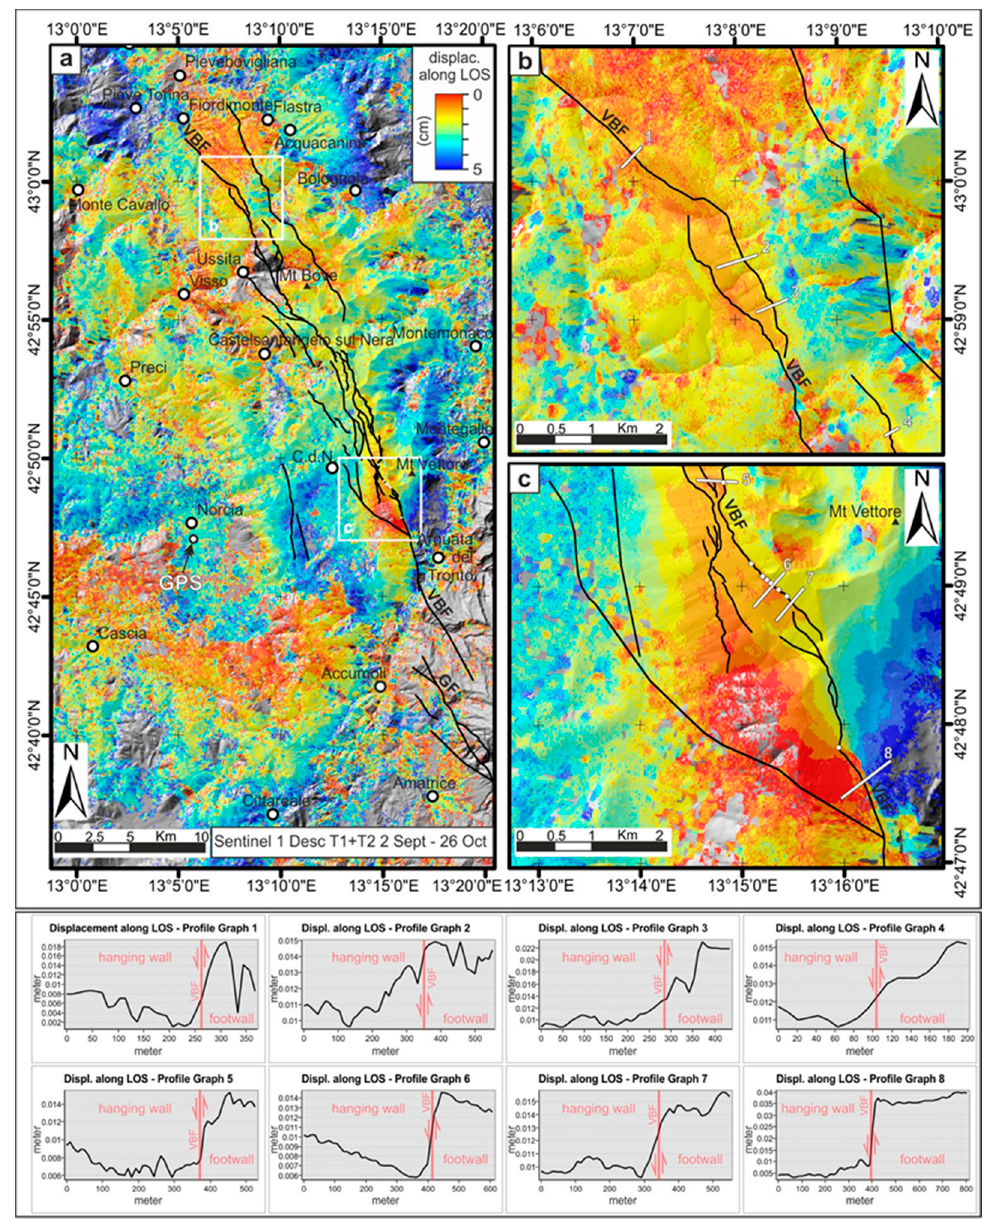
Figure 6. Same as Figure 5 but computed along the descending orbit. ( a ) Relative displacement field computed over high-coherence areas. The traces of the Vettore-Bove (VBF) and northern Gorzano (GF) fault are shown as black lines. ( b ) and ( c ): same high-coherence sample areas shown in Figure 5 showing results from the descending orbit. A coherence map of the area is provided in Figure S4d–f.